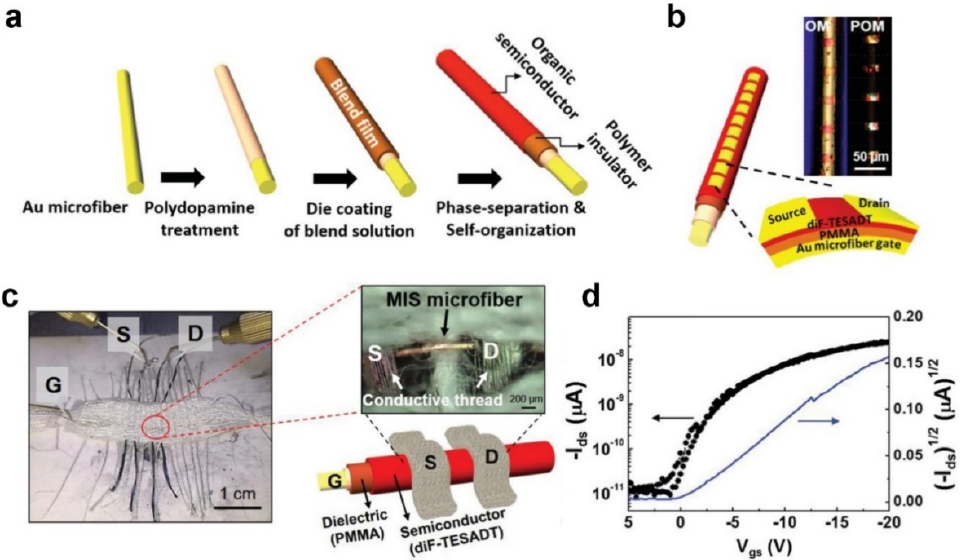
Figure 11. ( a ) Schematic illustration for the fabrication of fibriform OFETs using Au microfibers. ( b ) Schematic illustration and optical microscopy images of the fibriform OFETs. ( c ) Photograph, optical microscopy image, and schematic illustration of the fibriform OFETs embedded in the textiles. ( d ) Transfer characteristics of the fibriform OFETs at a source–drain voltage of −20 V. Reprinted from [71], copyright 2016 with permission from American Chemical Society.